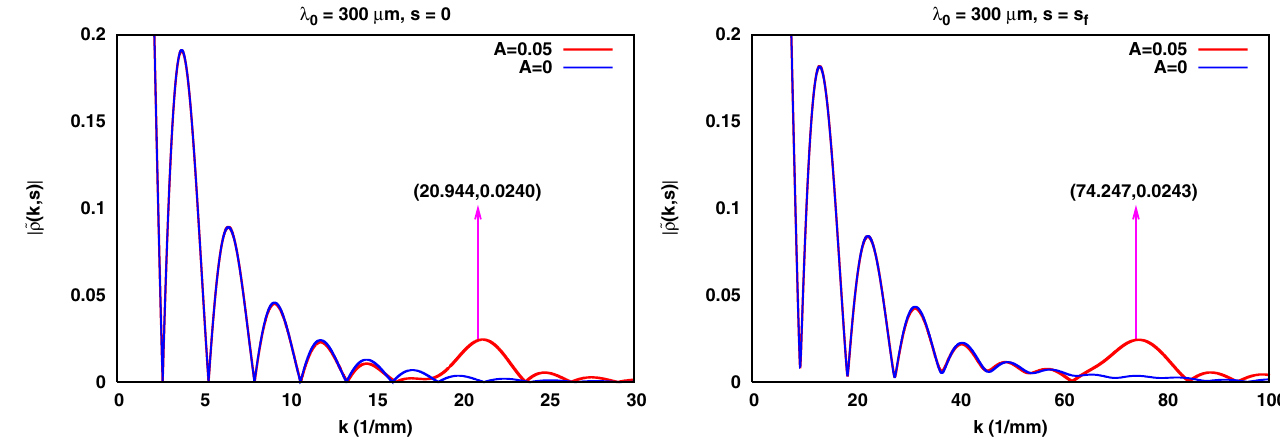
¼ 300 (cid:4) m with and without perturbation at s ¼ 0 (left) and s ¼ s FIG. 7. (Color) Fourier spectra for (cid:2) 0 C ð s Þ ; ~ (cid:3) ½ k C ð s Þ ; s (cid:2)g at s ¼ 0 and s ¼ s the points f k f 0 0